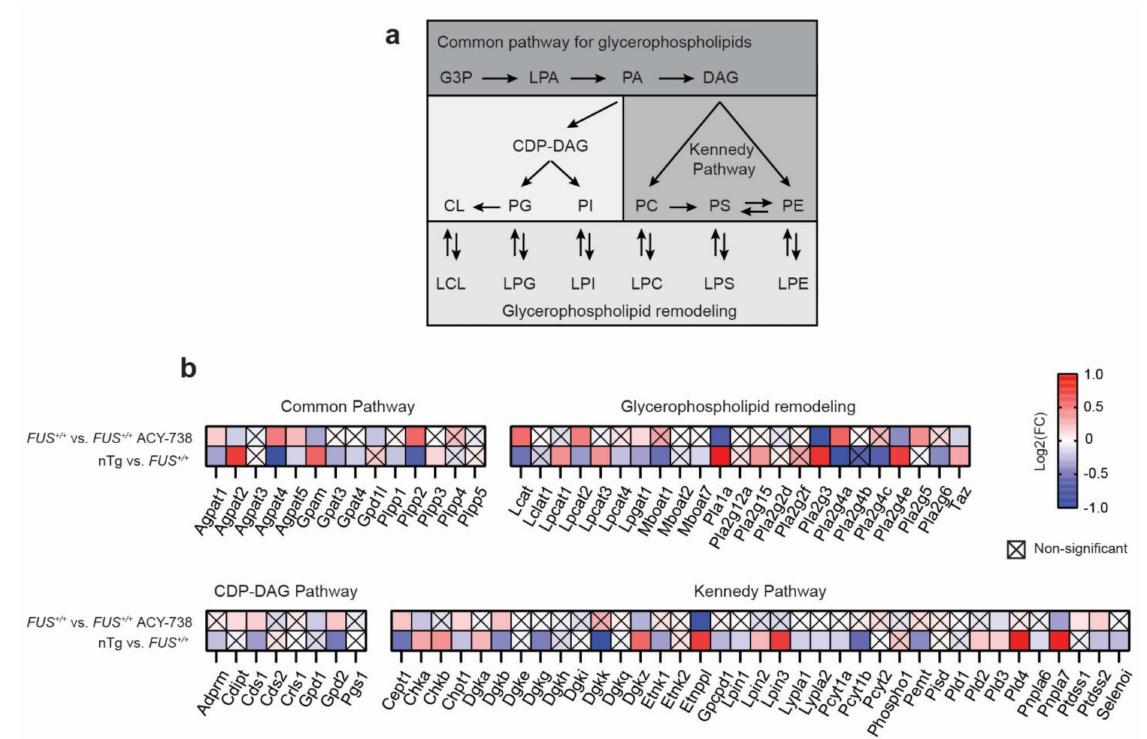
Figure 6. ACY-738 treatment mitigates transcriptomic defects of key enzymes implicated in glycerophospholipid metabolism. ( a ) Schematic of glycerophospholipid metabolism. ( b ) Heatmap showing color-coded differential expression of significantly down- (blue) or upregulated (red) genes involved in glycerophospholipid biosynthesis and remodeling in the spinal cord of 60-day-old mice. Data are represented as log2 fold change (FC). Crossed squares represent non-significant comparisons. Statistical significance was calculated by 1-way ANOVA. Only genes with a p > 0.05, FDR adjusted, were considered as significantly dysregulated. n = 6 per